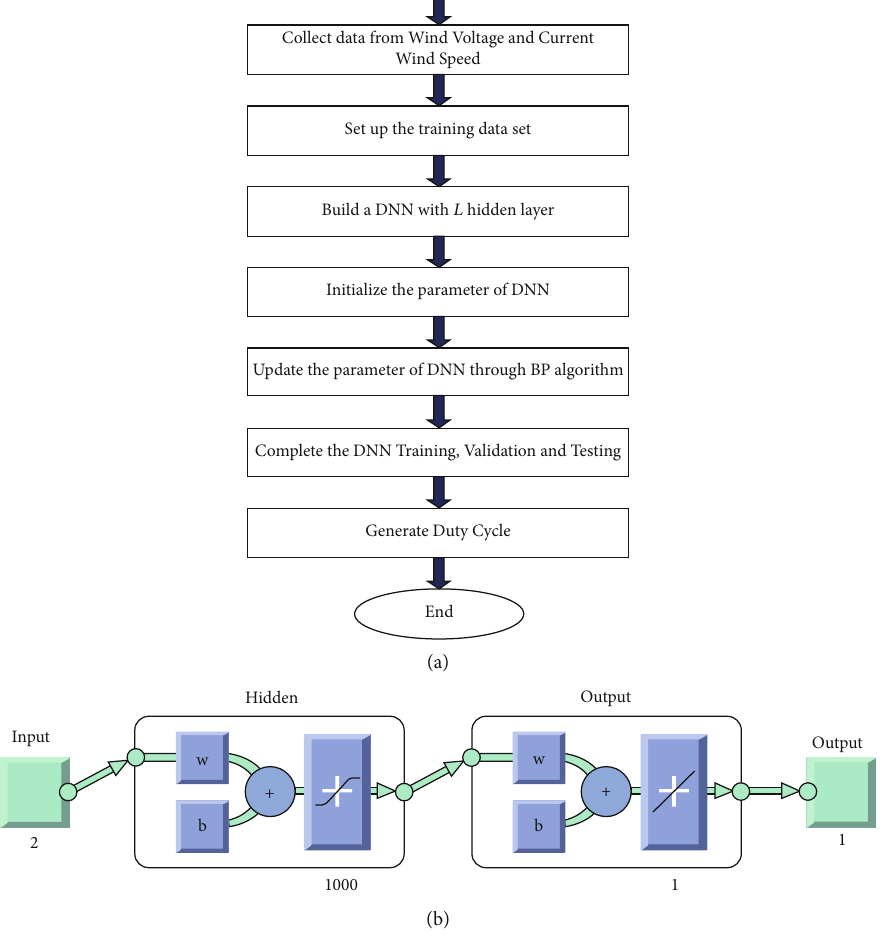
Figure 13: (a) Flow chart of DNN model of a wind-based MPPT system. (b) DNN model of a wind-based MPPT